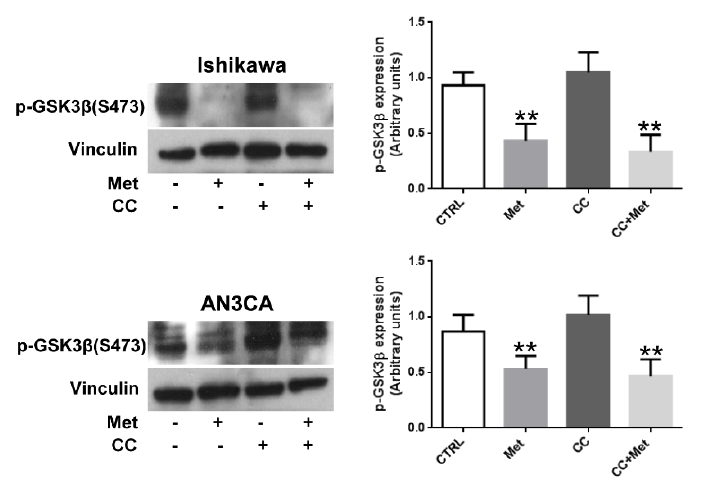
Figure 6. Metformin inhibits GSK3 β phosphorylation in endometrial cancer cells. Ishikawa or AN3CA cells were treated or not for 24 h with 5 mM metformin or 10 µ M CC or pretreated for 1 h with 10 µ M CC followed by treatment with 5 mM metformin. Total cellular proteins were extracted and Western blot experiments were performed with antibodies against p-GSK3 β (Ser9) or vinculin (loading control), as described in the 2.3 section. Values shown represent the mean (± s.d.) of three independent experiments. ** p < 0.05.